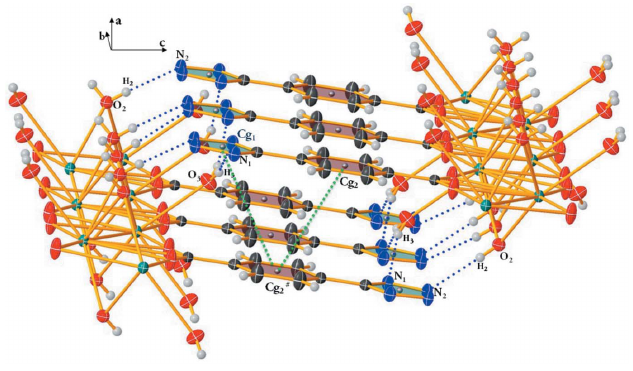
Figure 4 Hydrogen bonds (blue dashed lines) and (cid:2) -stacking interactions (green dashed lines) in the crystal packing of compounds (I) and